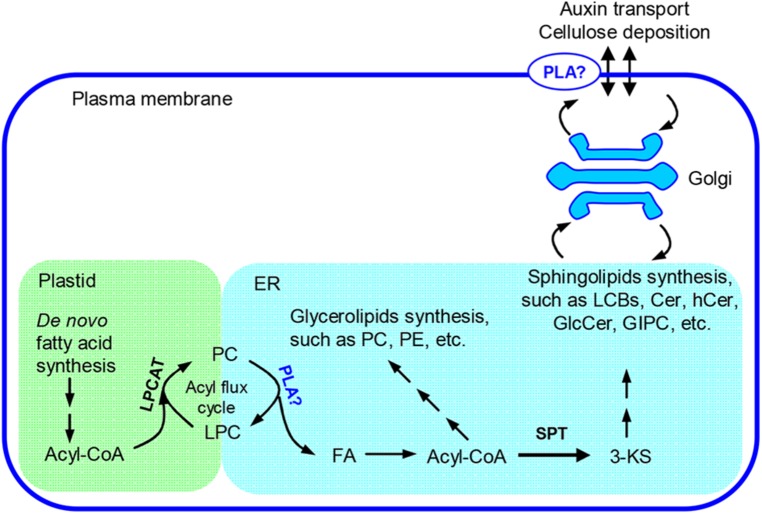
Proposed role of pPLAIIIβ on sphingolipid synthesis. In plants, fatty acids are primarily synthesized in plastids and need to be transferred to the ER for assembly of glycerolipids, such as PC and PE, as well as sphingolipids, such as long chain bases(LCBs), Cer, hCer, and GlcCer (Bates et al., 2013; Markham et al., 2013). The synthesis of GIPC takes place at Golgi apparatus (Markham et al., 2013). An acyl flux cycle was proposed for the trafficking of fatty acids from plastids to ER, in which the synthesis of PC was catalyzed by LPCAT and the hydrolysis of PC by PLAs (Lands, 1960; Wang et al., 2012). pPLAIIIβ could be one type of PLA that participates in the acyl flux cycle and contributes to synthesis of the complex membrane lipids. 3-KS, 3-keto-sphinganine; Cer, ceramide; ER, endoplasmic reticulum; FA, free fatty acids; GlcCer, glucosylceramide; GIPC, glycosylinositolphosphoceramide; hCer, hydroxyceramide; LPC, lysophosphatidylcholine; LPCAT, LPC acyltransferase; PC, phosphatidylcholine; PE, phosphatidylethanolamine; PLA, phospholipase A; SPT, serine-palmitoyltransferase.